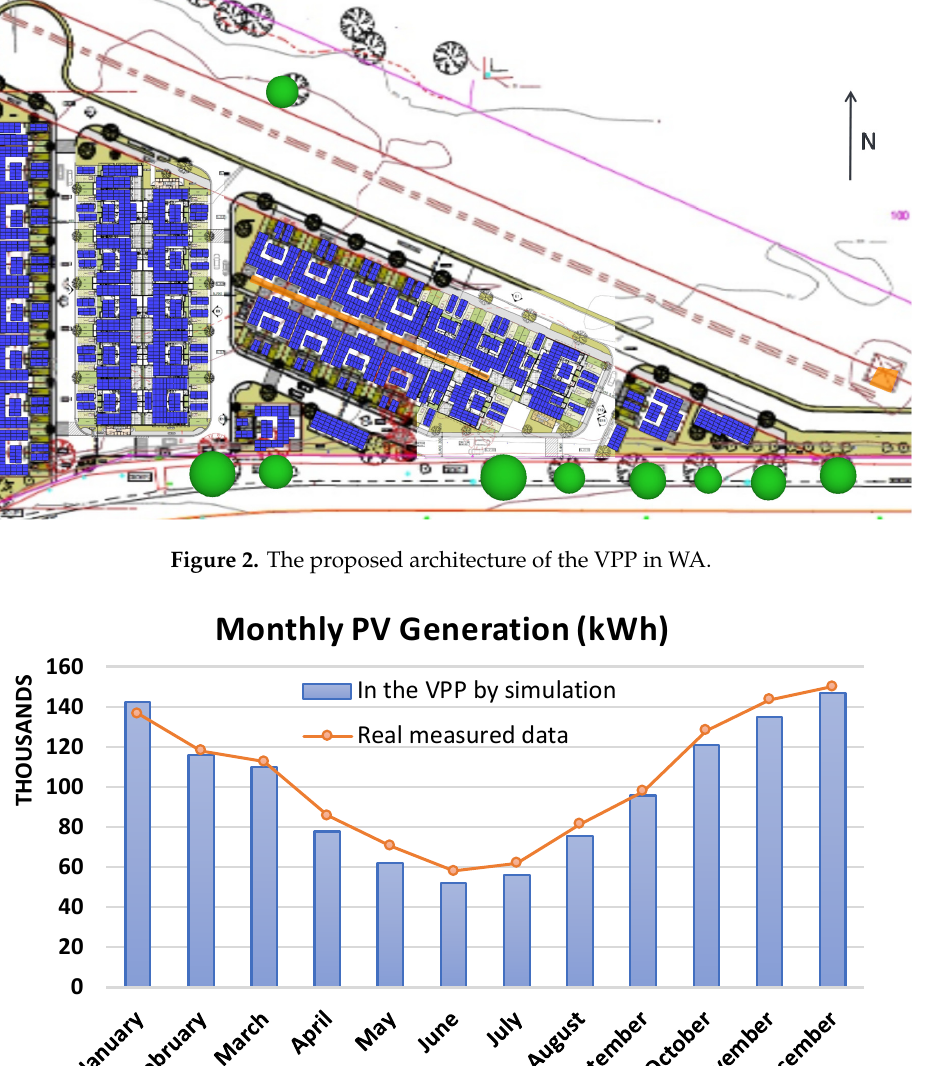
Figure 3. The photovoltaic (PV) generation during a year within the VPP compared to the real data measured in WA.